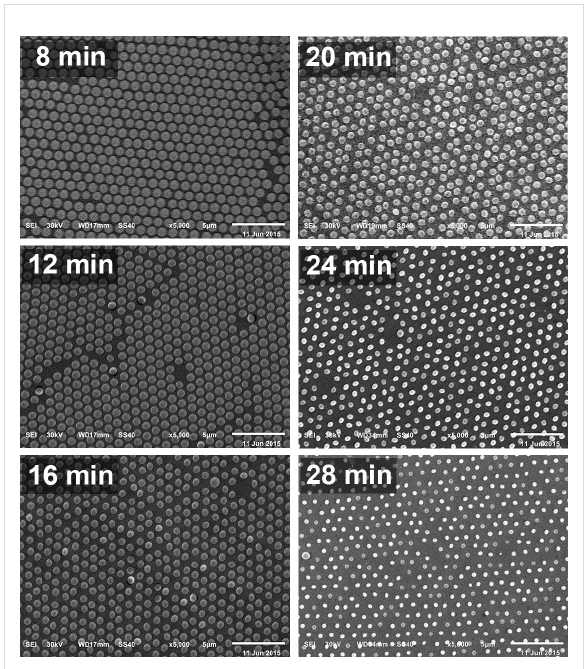
Figure 3: SEM images of the sphere masks etched by oxygen plasma at 18 W with different times (8–28 min). A decrease in the diameter of the polystyrene particles with an increase of the etching time can be seen. The periodicity is not affected by the etching process as the spheres remain at their initial position. Substrates were covered by ~45 nm Au with a ~3 nm Ti adhesion layer after the etching process. All scale bars are 5 μ